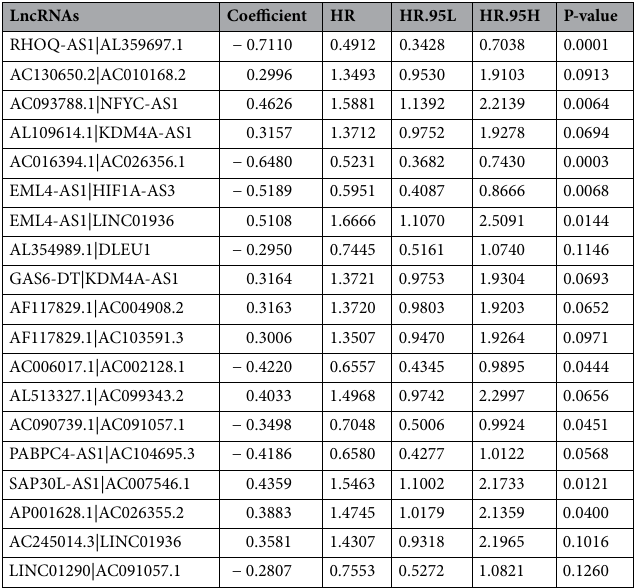
Table 1. 20 pairs of prognostic aging-related lncRNA pairs multivariate COX regression analysis results. HR hazard ratio, HR.95L 95% CI lower limit, HR.95H 95% CI upper